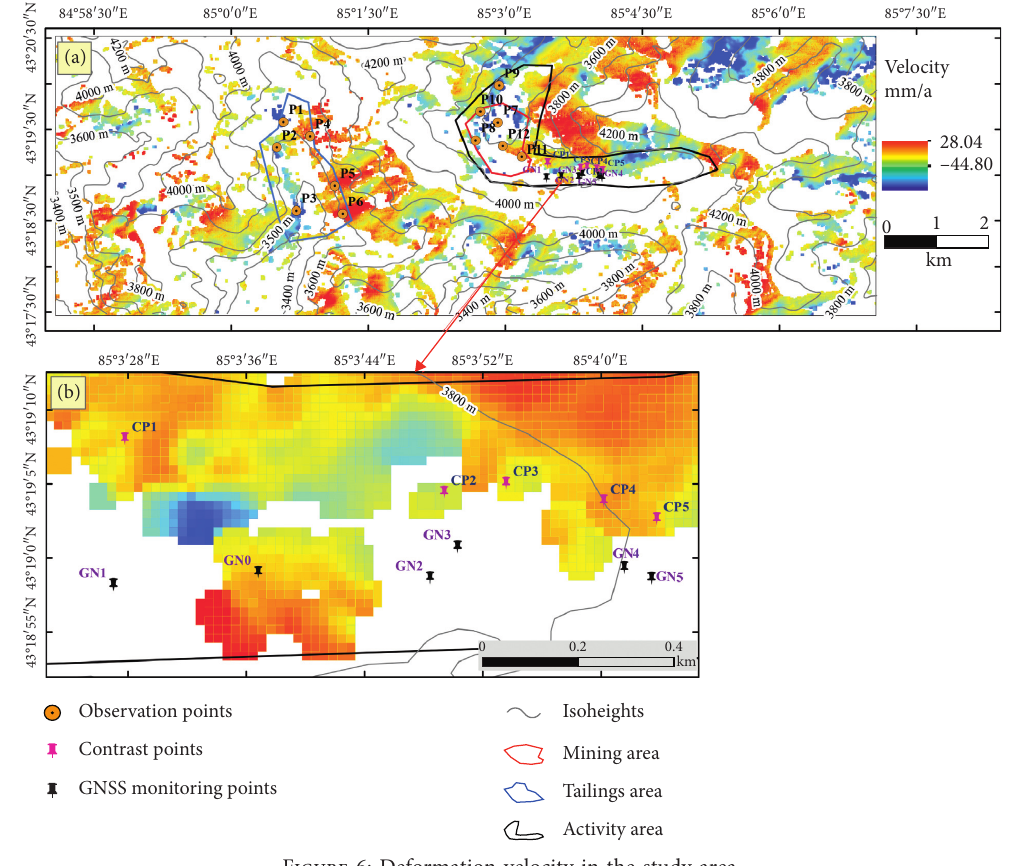
Figure 6: Deformation velocity in the study area.